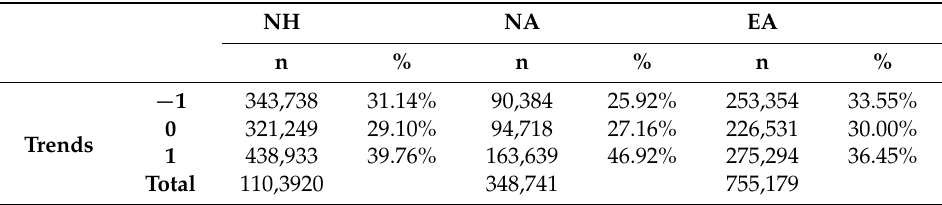
Table 4. Statistics (number of pixels and percentages) of significant trends in correlations between LOS and GSI (Figure 7) at hemispheric and continental scales ( p = 0.1). NH NA